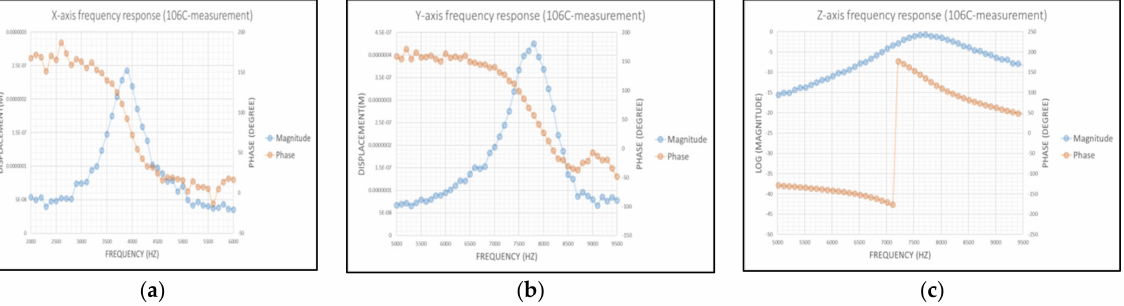
Figure 26. ( a ) Measured bode plot of the MEMS structure along the X -axis; ( b ) measured bode plot of the MEMS structure along the Y -axis; ( c ) measured bode plot of the MEMS structure along the Z